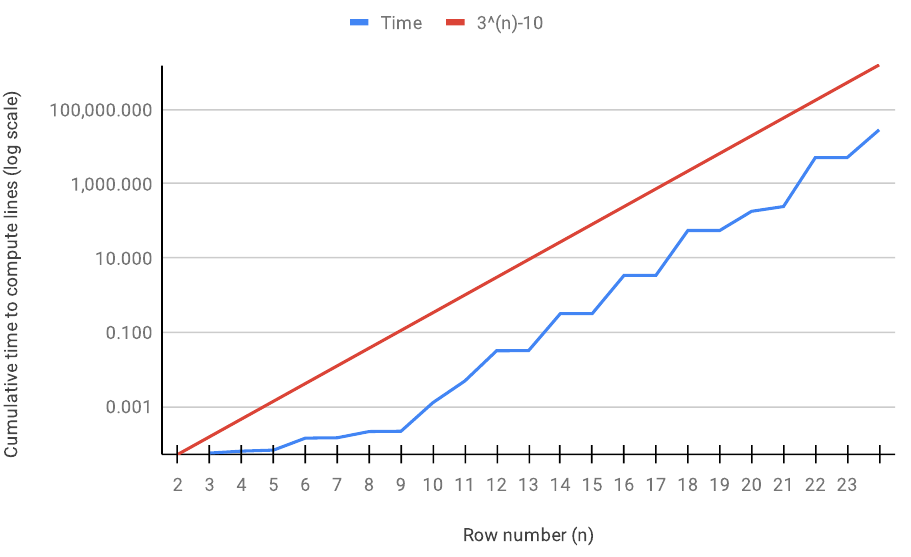
Figure 17. Cumulative time to compute any row n , with 3 n